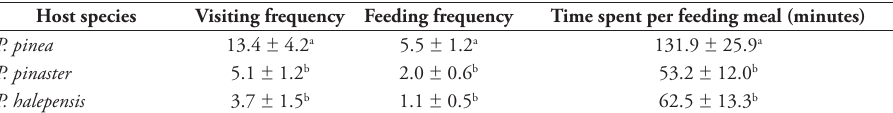
Table 2. Bug behaviour averages ( ± SE) in the cone preference trials. Different letters within a column indicate significant differences between the values per host species after GLM tests (p-value=0.05).